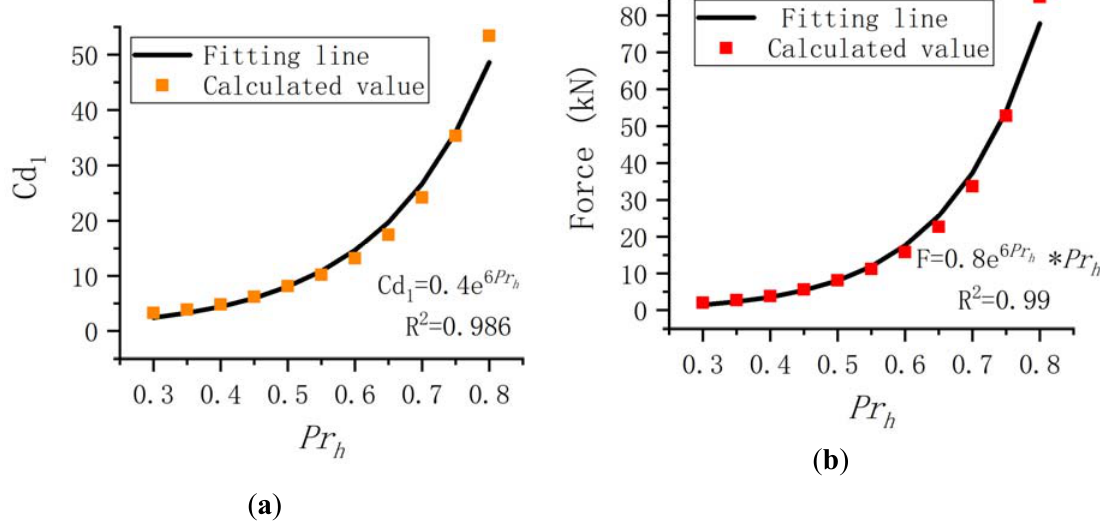
Figure 9. ( a ) Drag coefficient and ( b ) force at different water blocking rates (data sources: C1–C11).